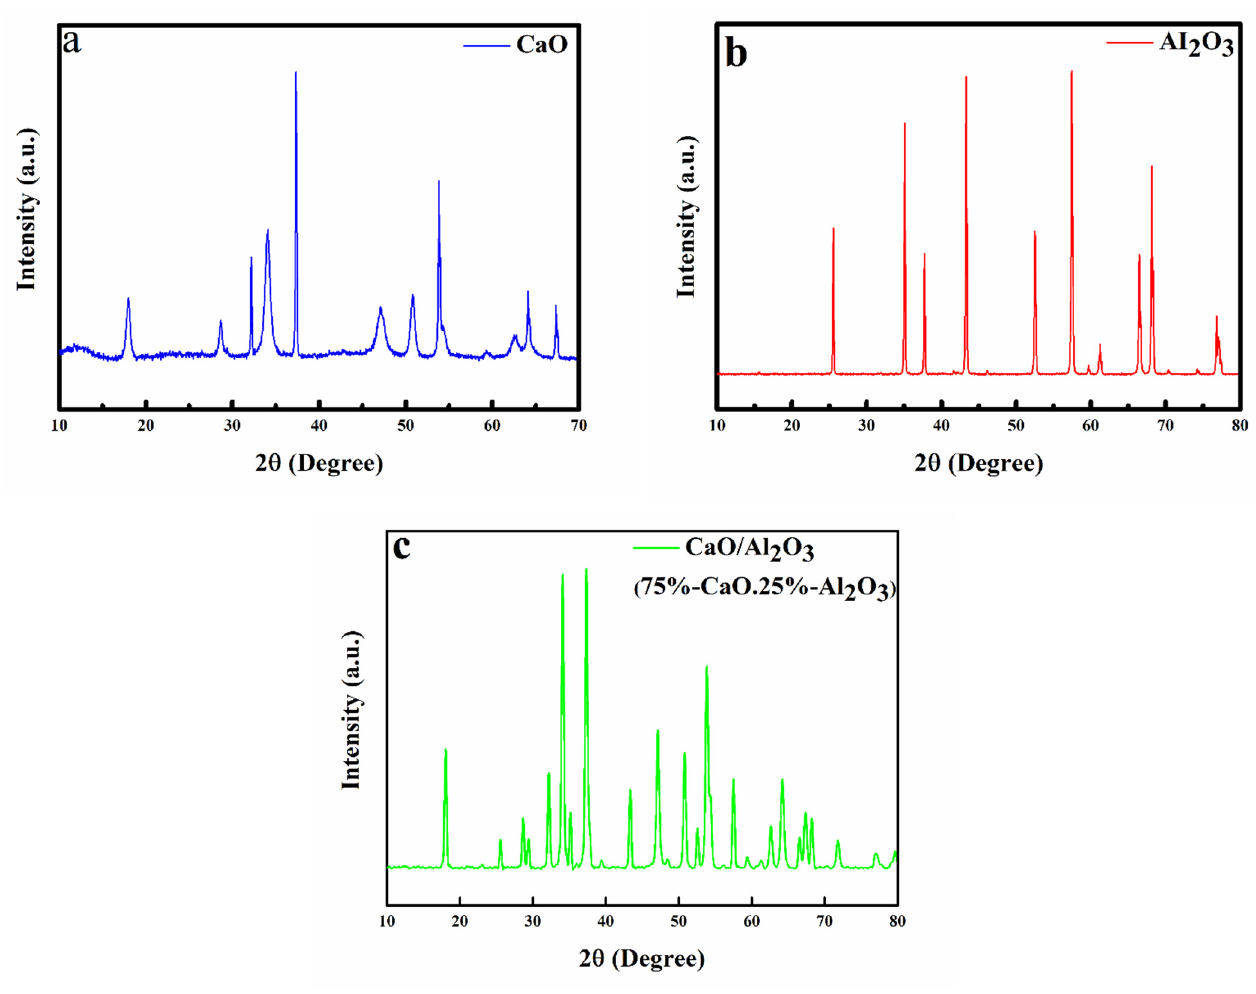
Figure 3. XRD patterns of ( a ) CaO, ( b ) Al 2 O 3 and ( c ) CaO/Al 2 O 3.